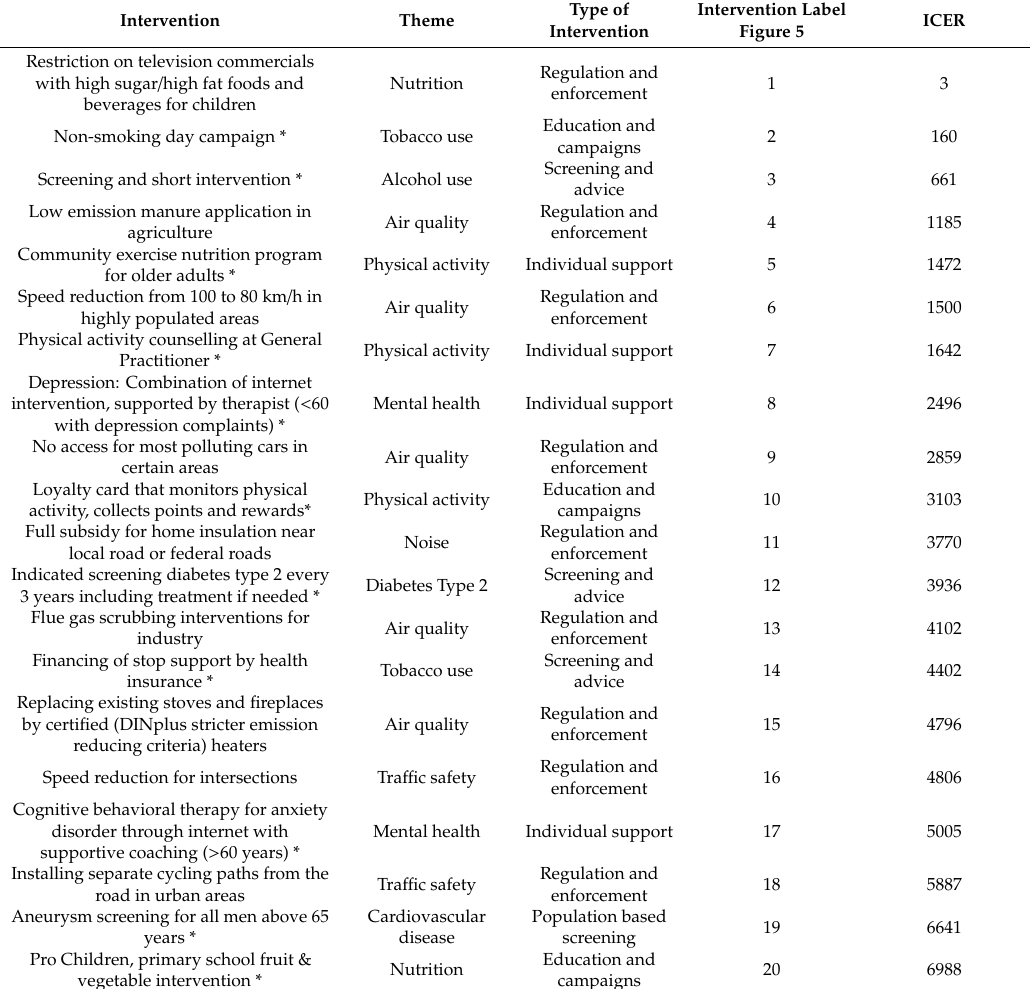
Table 3. Top 20 of cost-e ff ective interventions (ranked from lowest to highest ICER € 2015). Intervention Theme